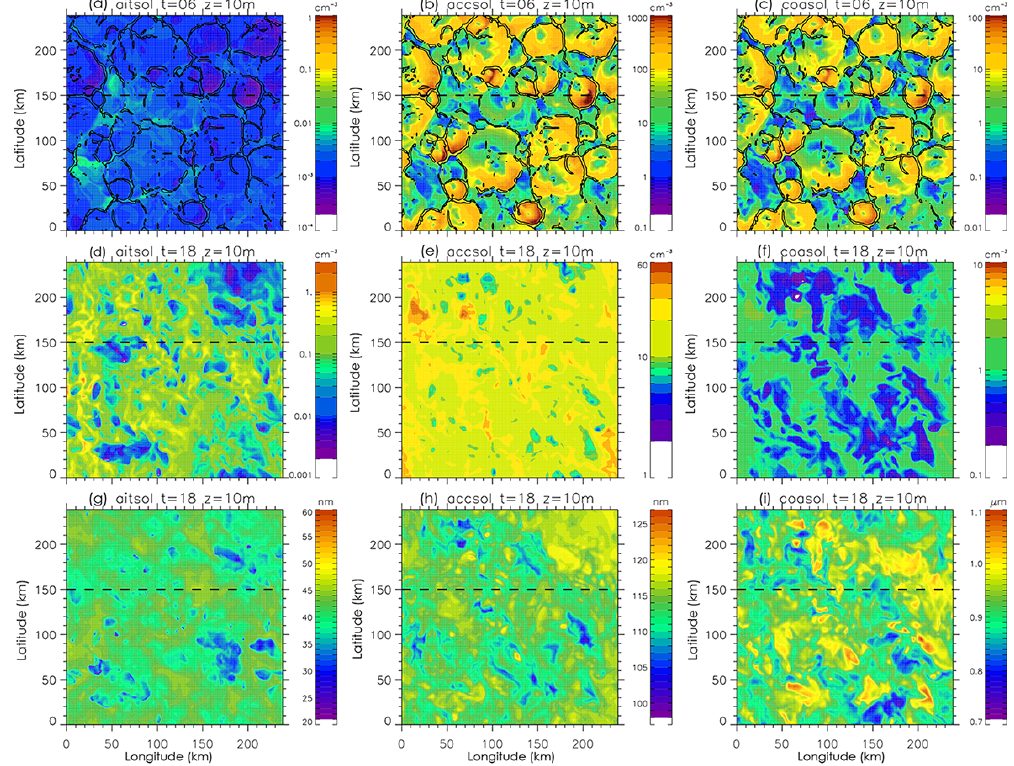
Figure 3. Snapshot spatial variations in the number concentrations (a–f) and geometric-mean radius (g–i) of the aerosol particles in the Aitken (aitsol; a , d , g ), accumulation (accsol; b , e , h ), and coarse (coasol; c , f , i ) soluble modes after 6h (in model spin-up) (a–c) and 18h (d–i) of integration. The black solid lines represent the surface vertical wind speed ( w = 5ms − 1 ) . Note that the colour scales are different. The dashed lines correspond to the transects shown in Figs. 5 and 9.